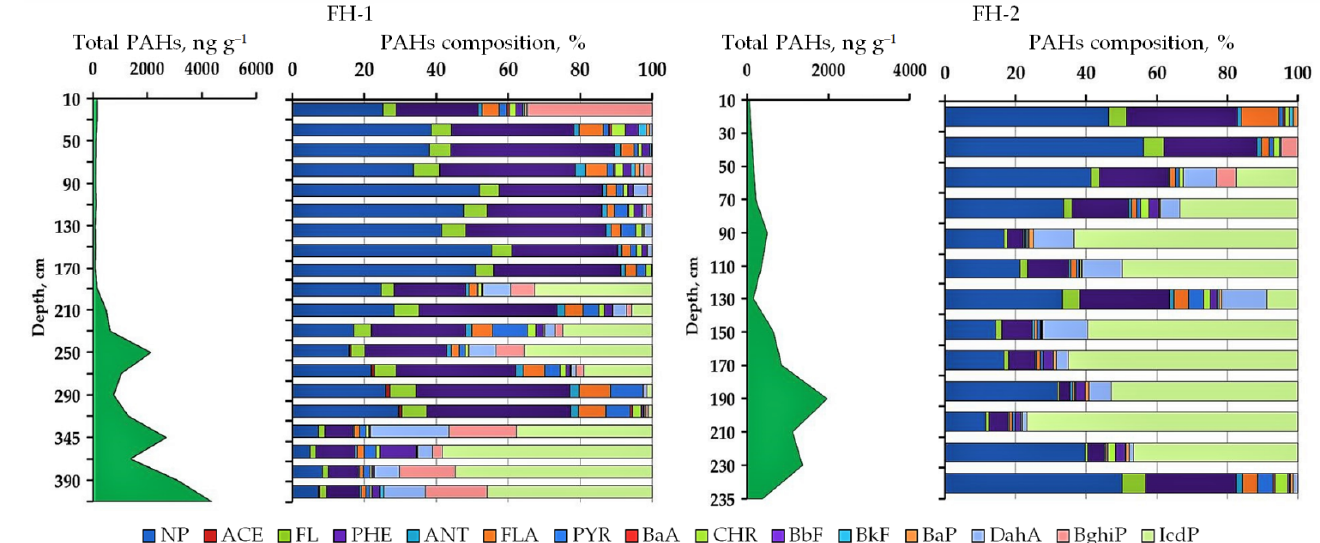
Figure 4. The profile distribution and composition of PAHs in studied histosols.